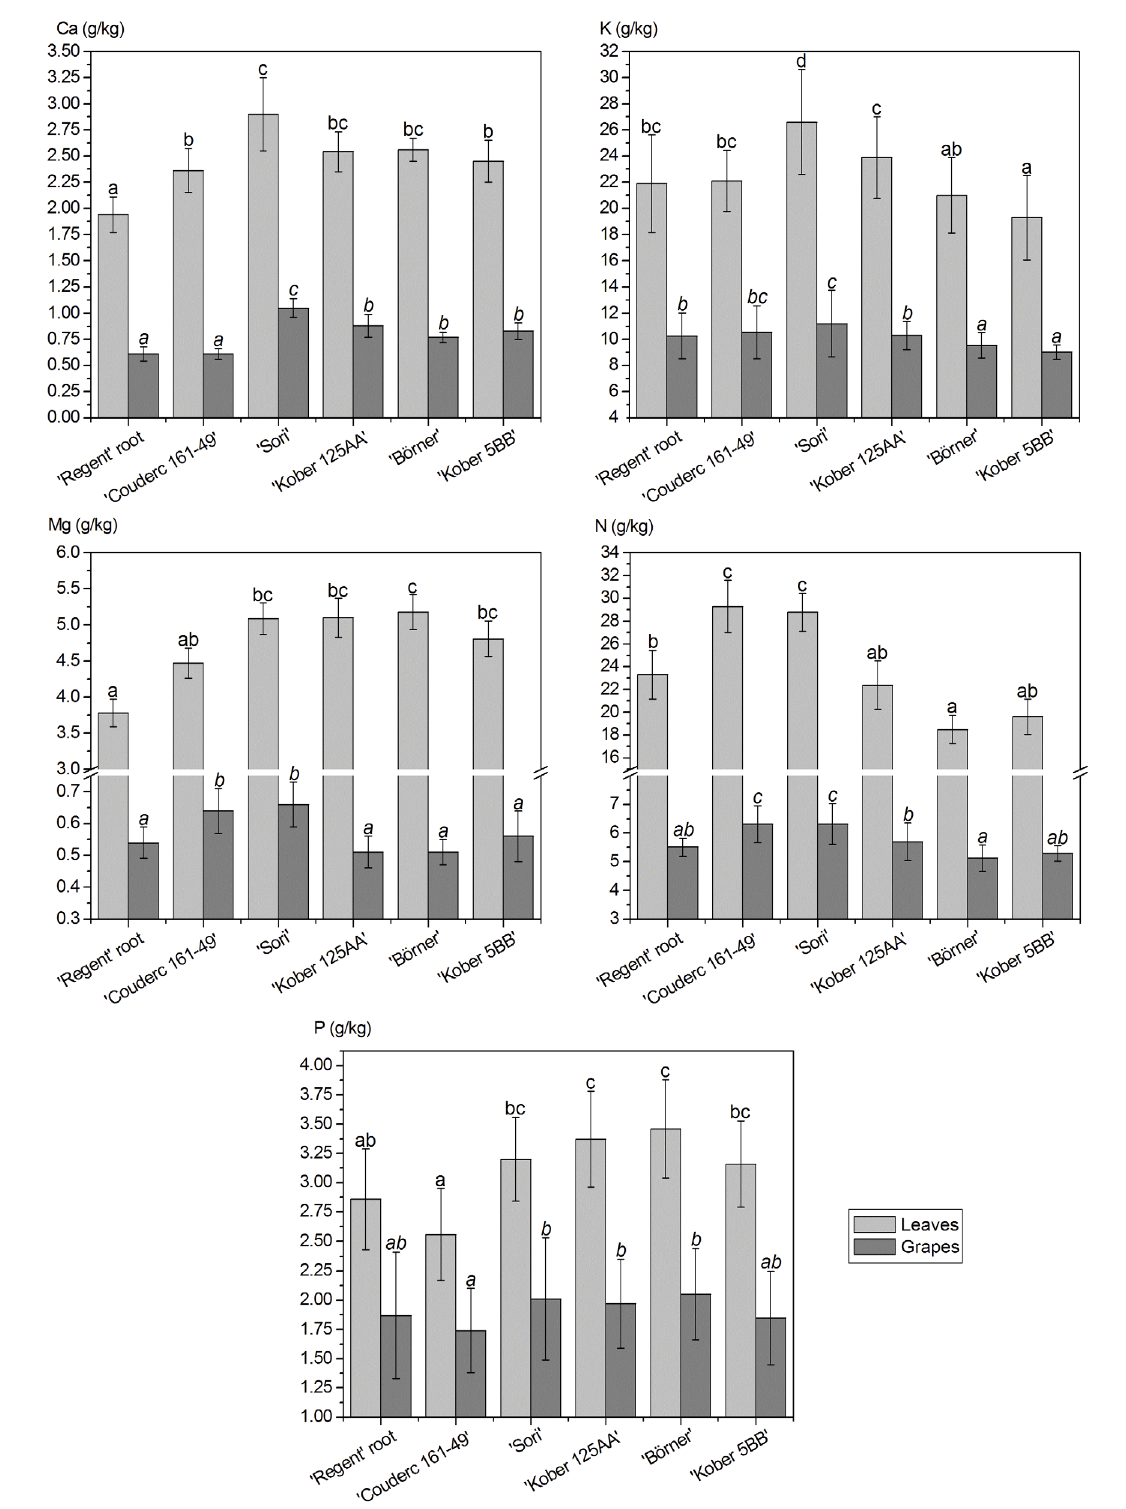
Fig. 1: The average of macronutrient content (g/kg) in leaves and berries of the ‘Regent’ cultivar from the own-rooted and grafted vines during three years of study (2013-2015). Means having same letter were not significantly different by Tukey’s comparison at p < 0.05 level. Lowercase letters (a) indicate the means of leaves, and italic letters ( a ) of